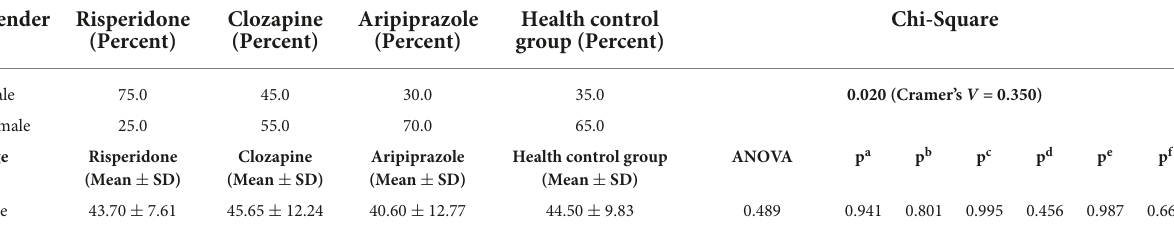
TABLE 1 Demographic data of the participants enrolled in the study.